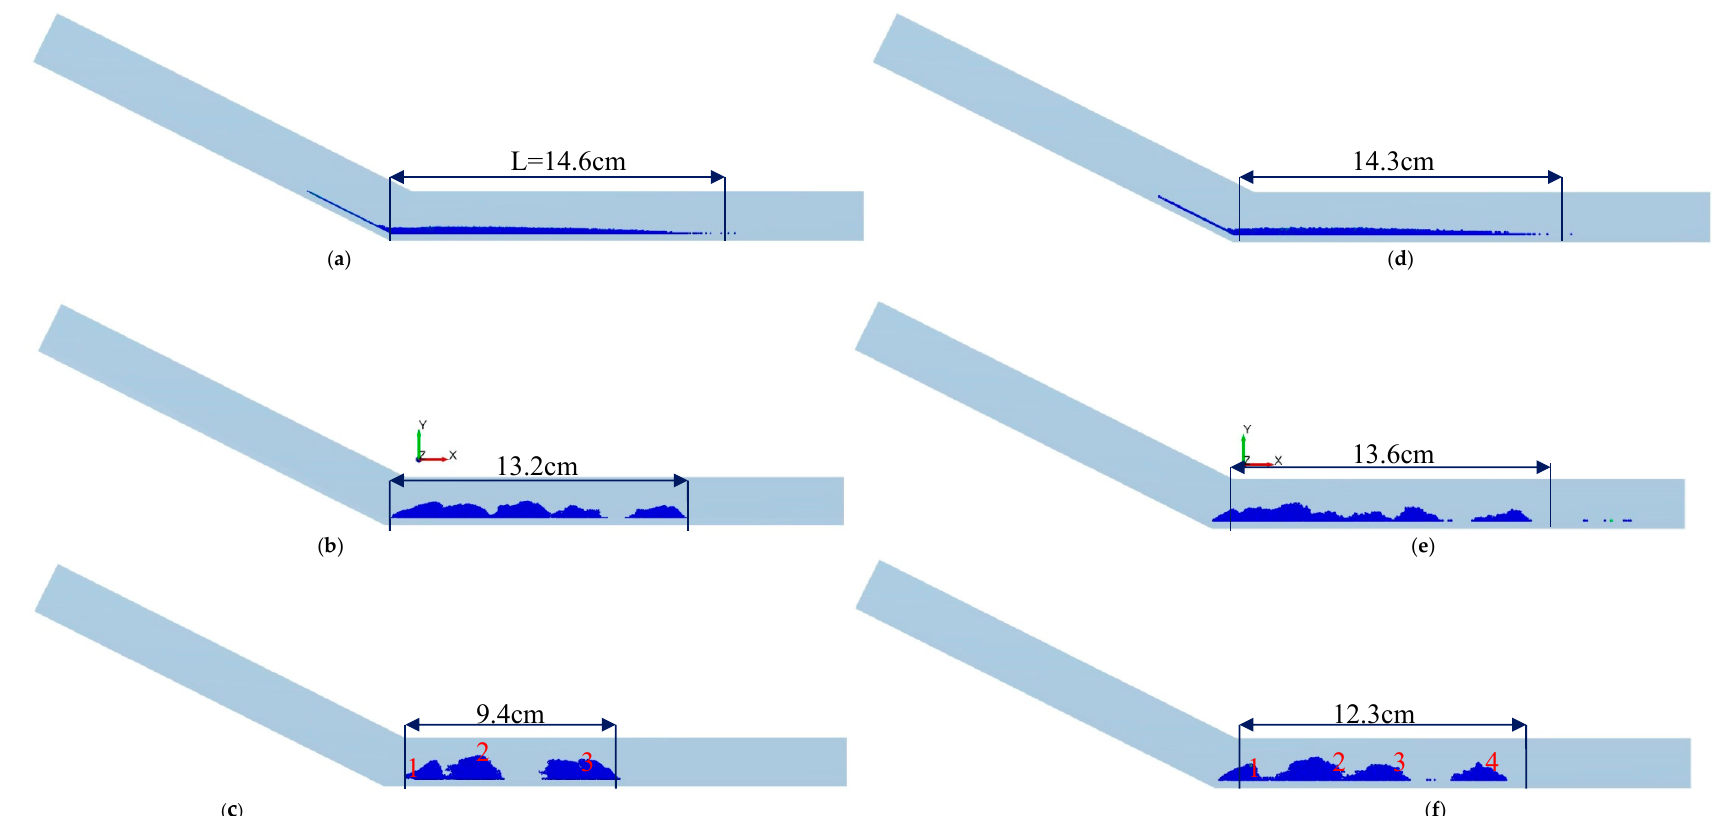
Figure 9. the final deposition of wetsoilgranular after the avalanche triggered at t=0.8s, ( a ) d=0.7mm, γ =0 J/m 2 ; ( b ) d=0.7mm, γ =0.1 J/m 2 ; ( c )d=0.7mm, γ =0. 2 J/m 2 ; ( d )d=1mm, γ =0 Figure 9. The final deposition of wetsoilgranular after the avalanche triggered at t = 0.8 s, ( a ) d = 0.7 mm, γ = 0 J / m 2 ; ( b ) d = 0.7 mm, γ = 0.1 J / m 2 ; ( c ) d = 0.7 mm, γ = J/m 2 ; ( e )d=1mm, γ =0.1 J/m 2 ; ( f )d=1mm , γ =0.2 J/m 2 . . 0.2 J / m 2 ; ( d ) d = 1 mm, γ = 0 J / m 2 ; ( e ) d = 1 mm, γ = 0.1 J / m 2 ; ( f ) d = 1 mm, γ = 0.2 J / m 2